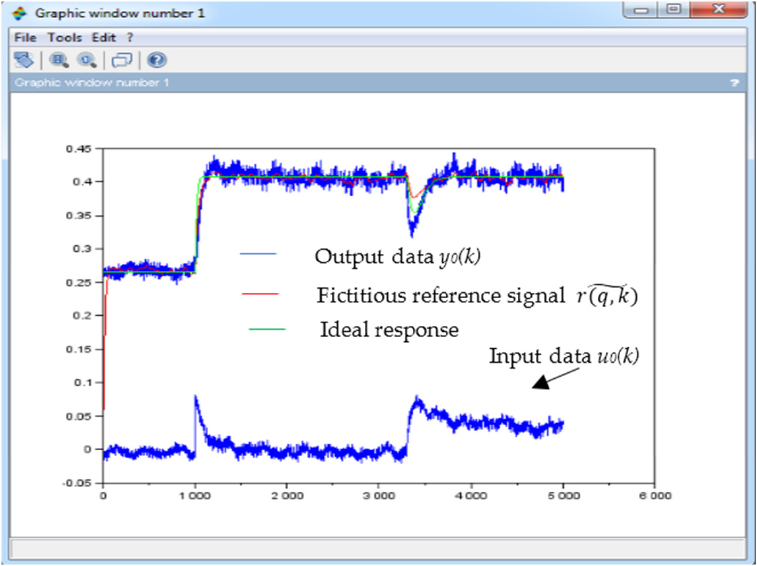
Figure 20. The state of fictitious reference signal r ( q , k ) after 100 iterations.